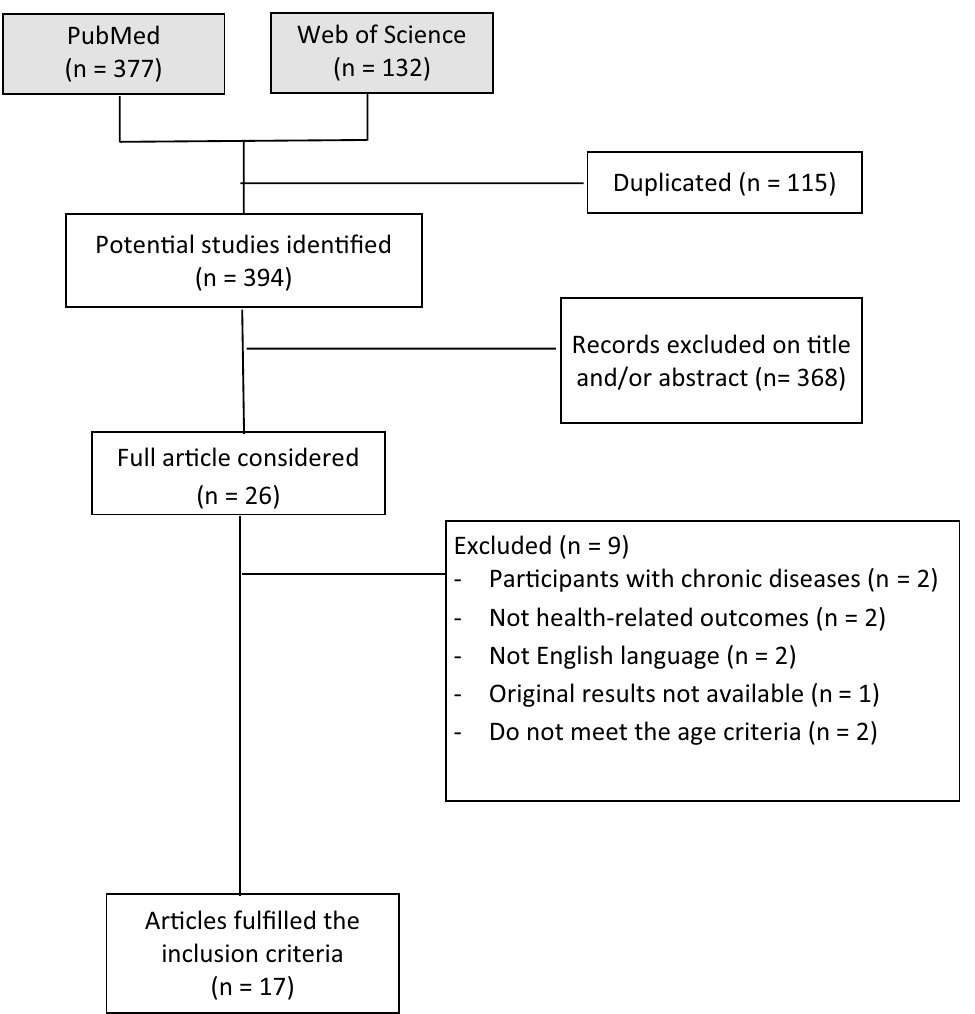
Fig. 1 Flowchart of the study